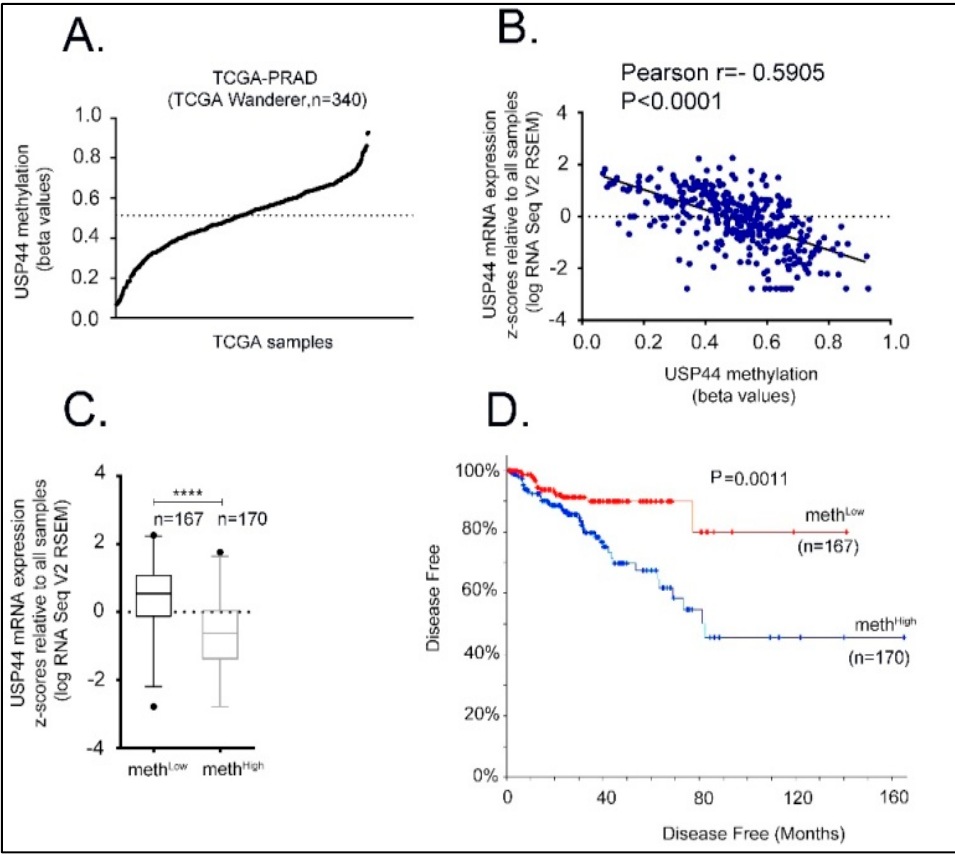
Figure 2. USP44 promoter methylation and its correlation to prostate adenocarcinoma patient data. ( A ) USP44 promoter methylation calculated by the average methylation values of cg23982858, cg009275554, cg22538054, and cg03308628 sites in TCGA prostate adenocarcinoma samples (TCGA- PRAD). Data were obtained from TCGA Wanderer database. Median USP44 promoter methylation among TCGA samples is indicated by the horizontal line. ( B ) Correlation between USP44 promoter methylation and mRNA expression. Expression data were obtained by TCGA-PRAD Firehose Legacy. ( C ) Boxplot of USP44 mRNA levels in meth High and meth Low groups. p < 0.0001. ( D ) Disease-free curve comparing meth High and meth Low groups. Patient data were obtained by TCGA-PRAD Firehose Legacy through cbioportal. Log-rank test p = 0.0011 (**** indicates p<0.0001 ).